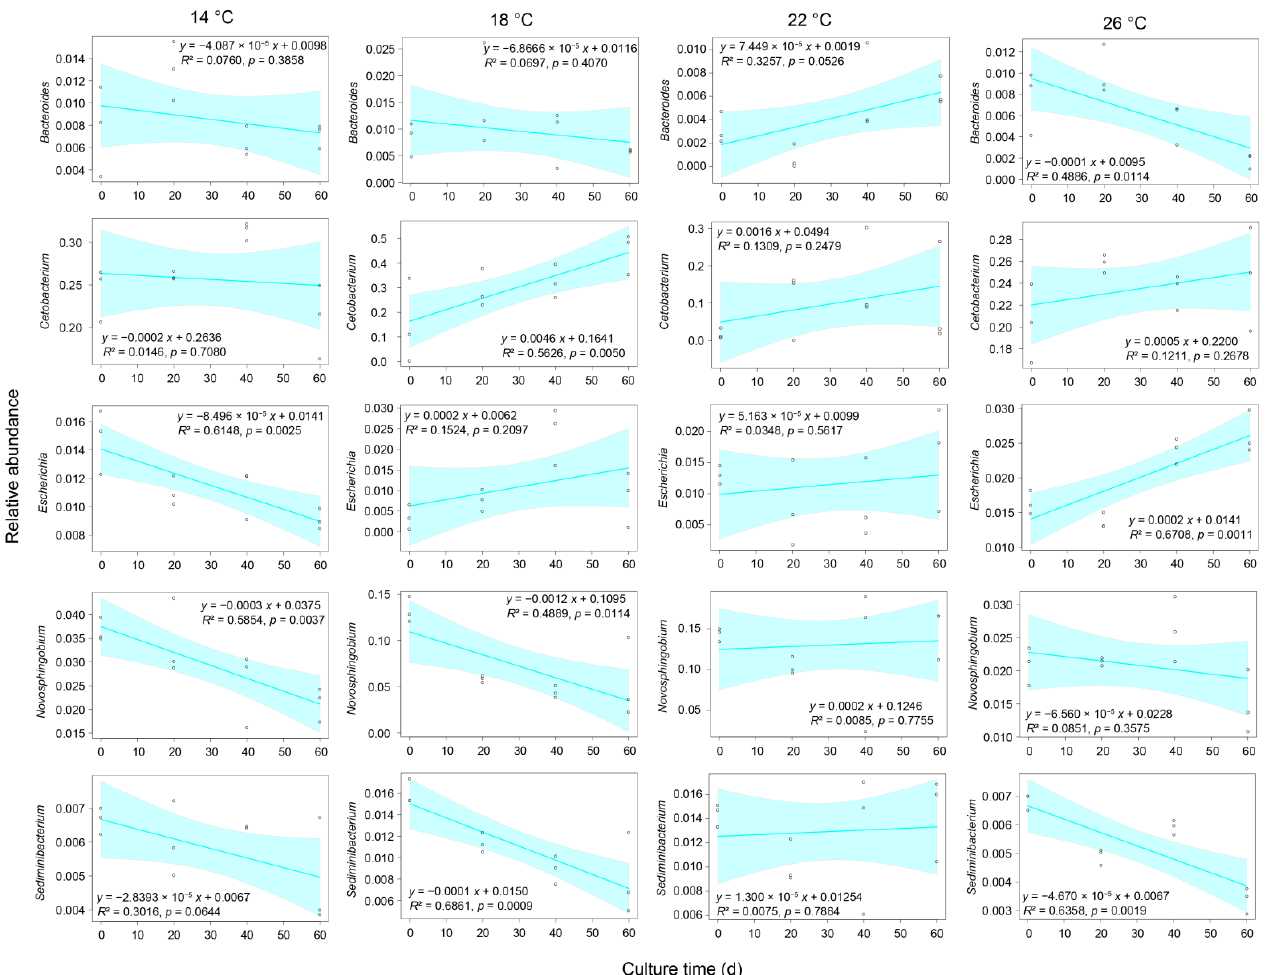
Figure 7. Correlation between the culture time and the relative abundances of Bacteroides , Cetobacterium , Novosphingobium , Sediminibacterium , and Escherichia in Percocypris pingi gut microbiota. Dots in the boxplots indicate values measured in samples.